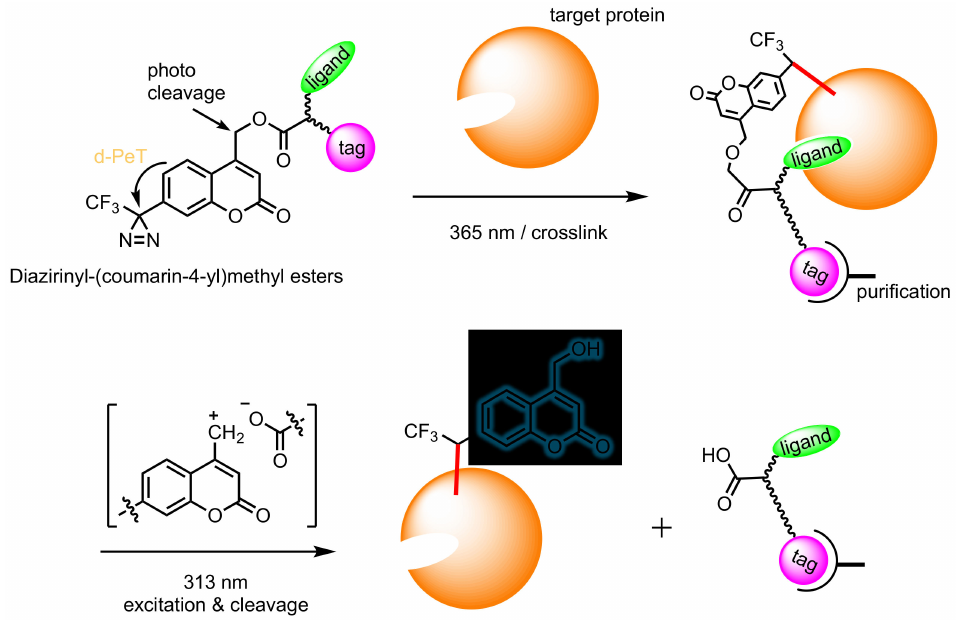
Figure 2. Concept of PAL with novel diazirinyl-coumarin based on (coumarin-4-yl)methyl